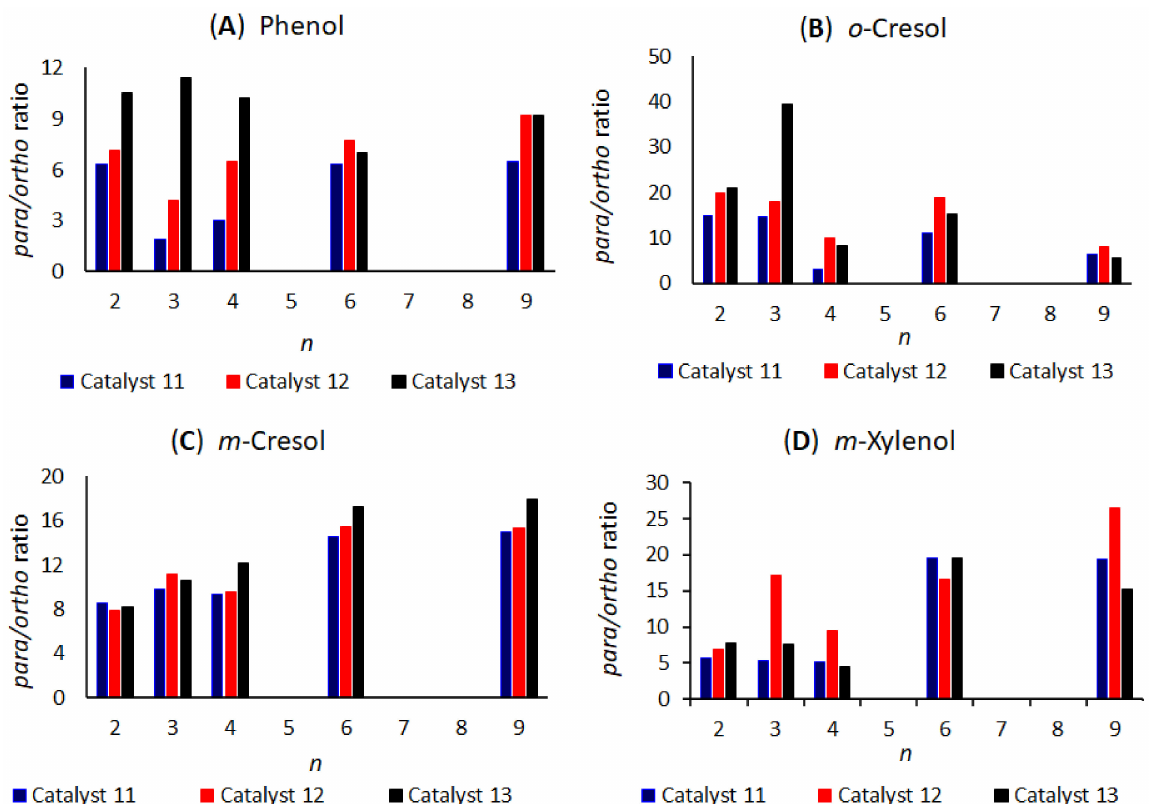
Figure 7. Effect of ω -substituted-1-(methylthio)alkanes [MeS(CH 2 ) n X] 11–13 on the selectivity of chlorination of phenols according to Scheme 1. Conditions: For phenol (Chart A ): 50 mmol substrate, 57.7 mmol SO 2 Cl 2 , 50 mg AlCl 3 , 50 mg sulphur compound, 2 h addition of SO 2 Cl 2 then 2 h at room temperature. For o -cresol (Chart B ): 50 mmol substrate, 57.7 mmol SO 2 Cl 2 , 250 mg AlCl 3 , 100 mg sulphur compound, 2 h addition of SO 2 Cl 2 then 2 h at room temperature. For m- cresol (Chart C ): 50 mmol substrate, 57.7 mmol SO 2 Cl 2 , 250 mg AlCl 3 , 100 mg sulphur compound, 2 h addition of SO 2 Cl 2 then 2 h at room temperature. For m- xylenol (Chart D ): 50 mmol substrate, 57.7 mmol SO 2 Cl 2 , 25 mg FeCl 3 , 30 mg sulphur compound, 25 mL dichloromethane (DCM), 2 h addition of SO 2 Cl 2 then 2 h at room temperature. In the case of m- cresol, the ortho- product 2 is a mixture of 2-chloro-3-methylphenol (minor) and 6-chloro-3-methylphenol